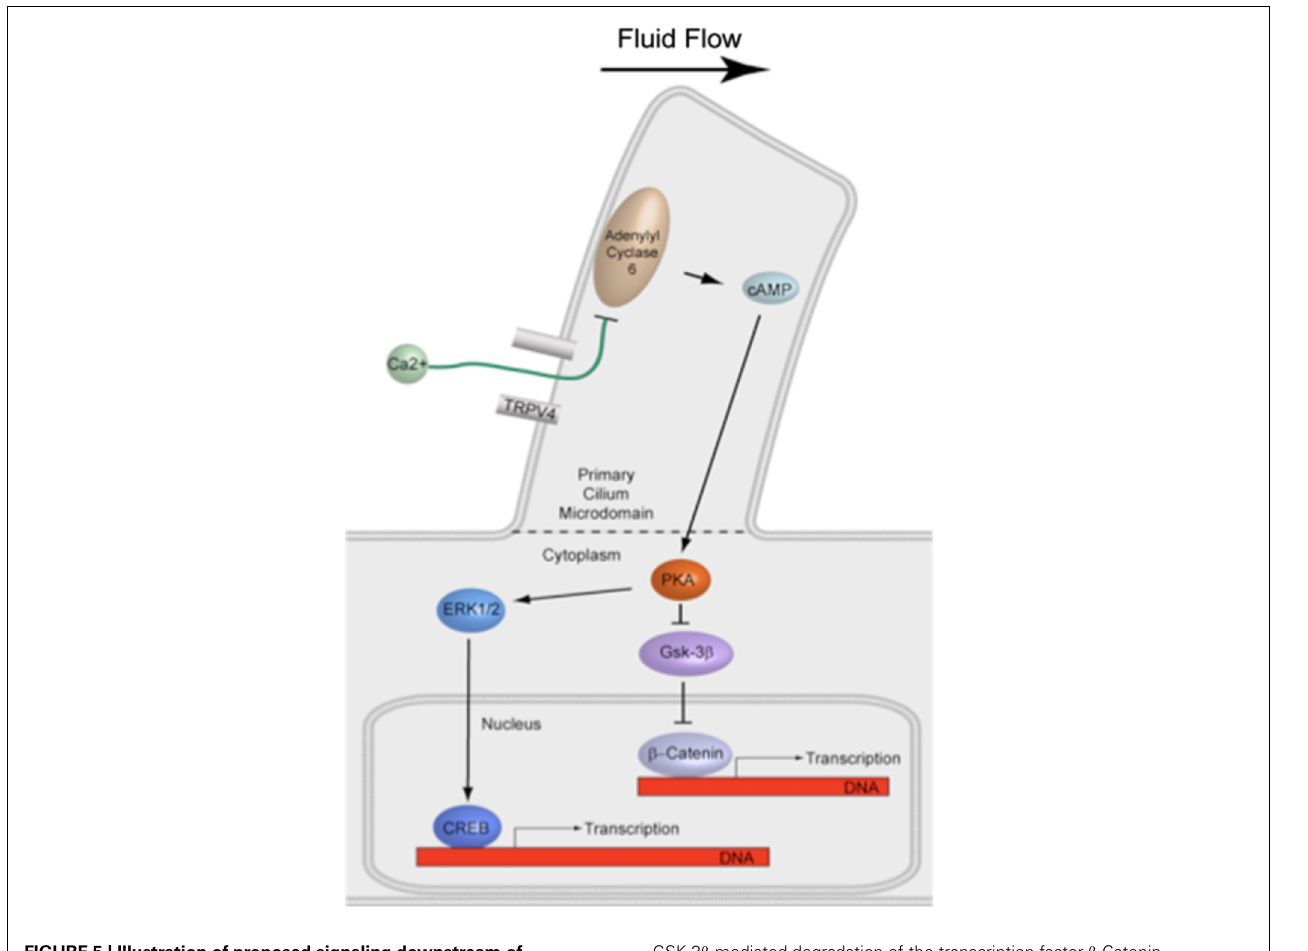
FIGURE 5 | Illustration of proposed signaling downstream of cilia-mediated mechanosensing in bone. PKA is known to activate the ERK1/2-CREB signaling cascade and also inhibit